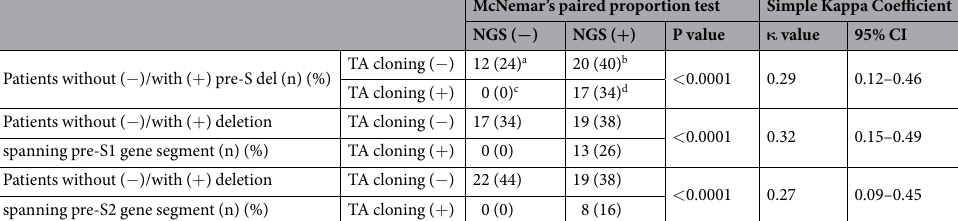
TA cloning ( − ) 12 (24) a